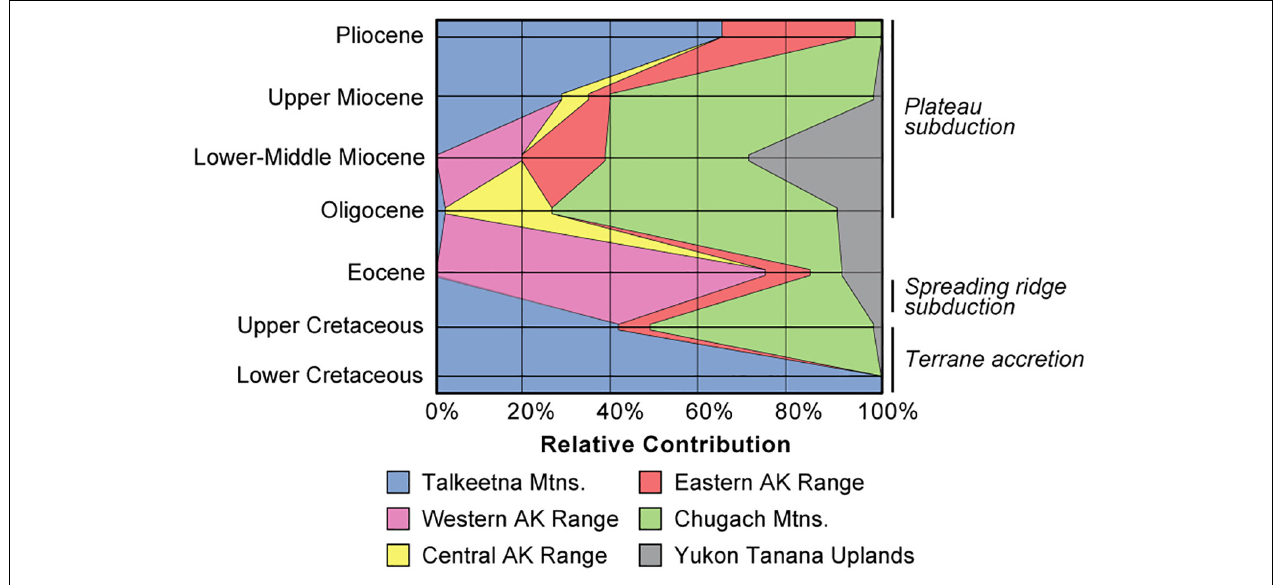
FIGURE 11 | Graph depicting temporal variations in relative contributions from the potential source regions in southern Alaska.